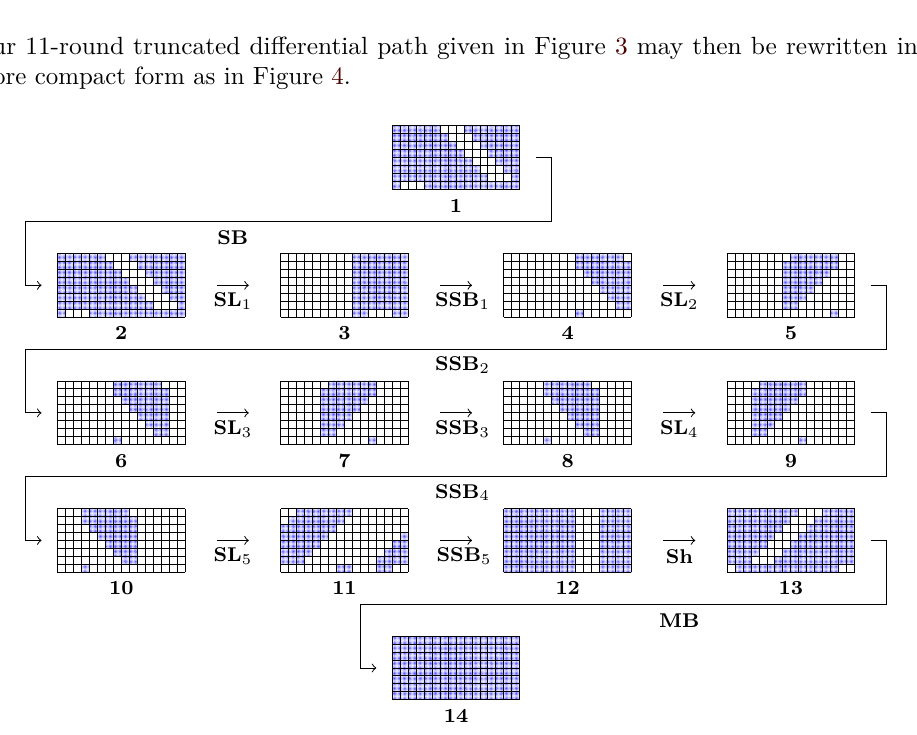
Figure 4: The 11-round truncated differential path with a SuperSBox